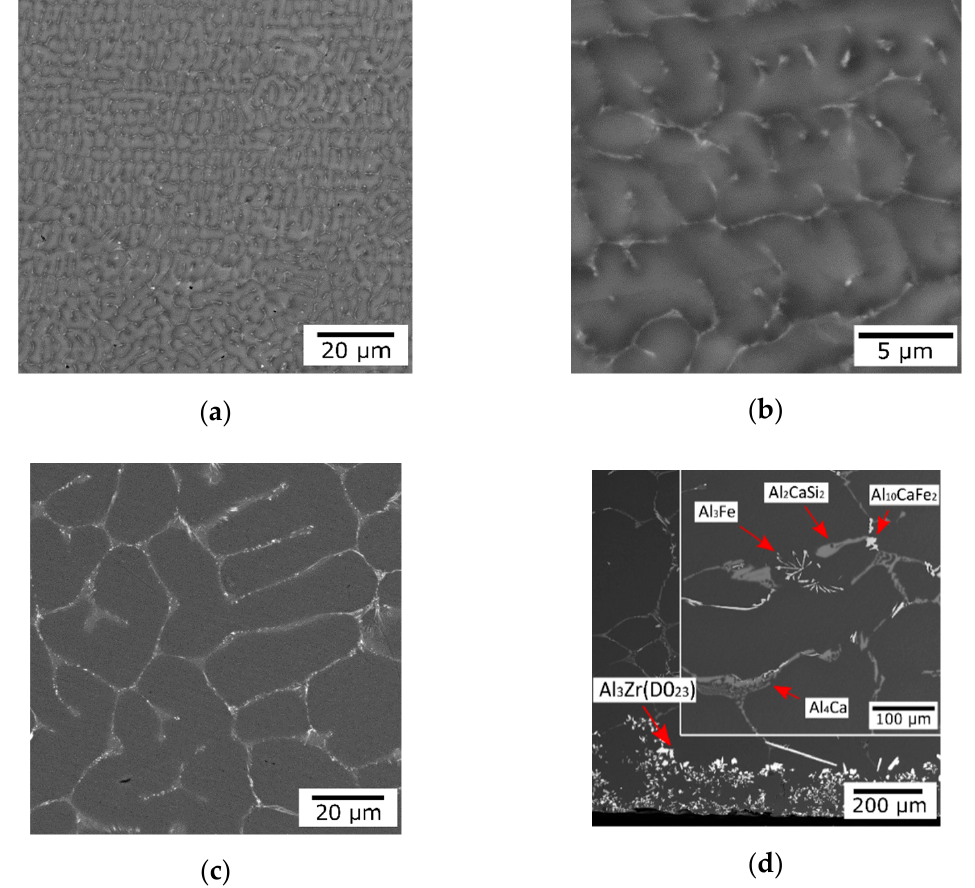
Figure 2. As-cast microstructure of alloy ACZ after various cooling velocities, SEM: ( a , b ) ~10 4 (12 mm EMC rod, R in Table 2), ( c ) ~20 K/s (10 mm × 40 mm × 200 mm ingot), ( d ) ~0.1 K/s (cooling in furnace).